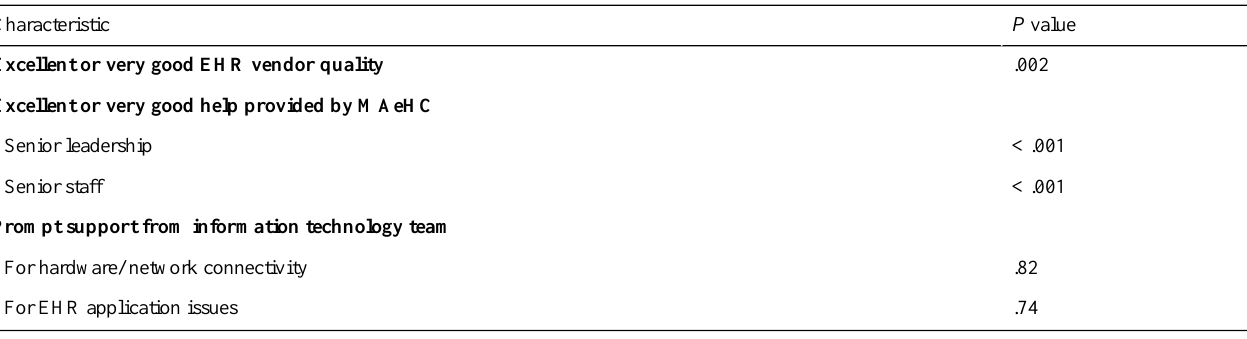
Table 3. Bivariate relationship between physicians feeling very satisfied with their practice following EHR adoption and their perceptions of EHR vendor characteristics (n =